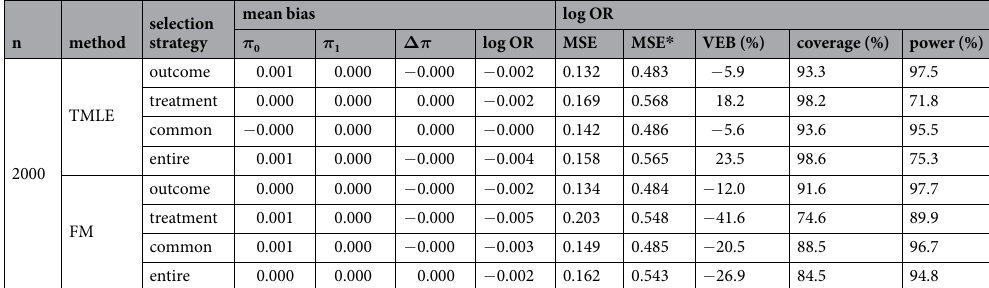
Table 1. Simulation results comparing the ATT estimation under the alternative hypothesis. * MSE in the presence of an unmeasured confounder. Theoretical values: π π θ =